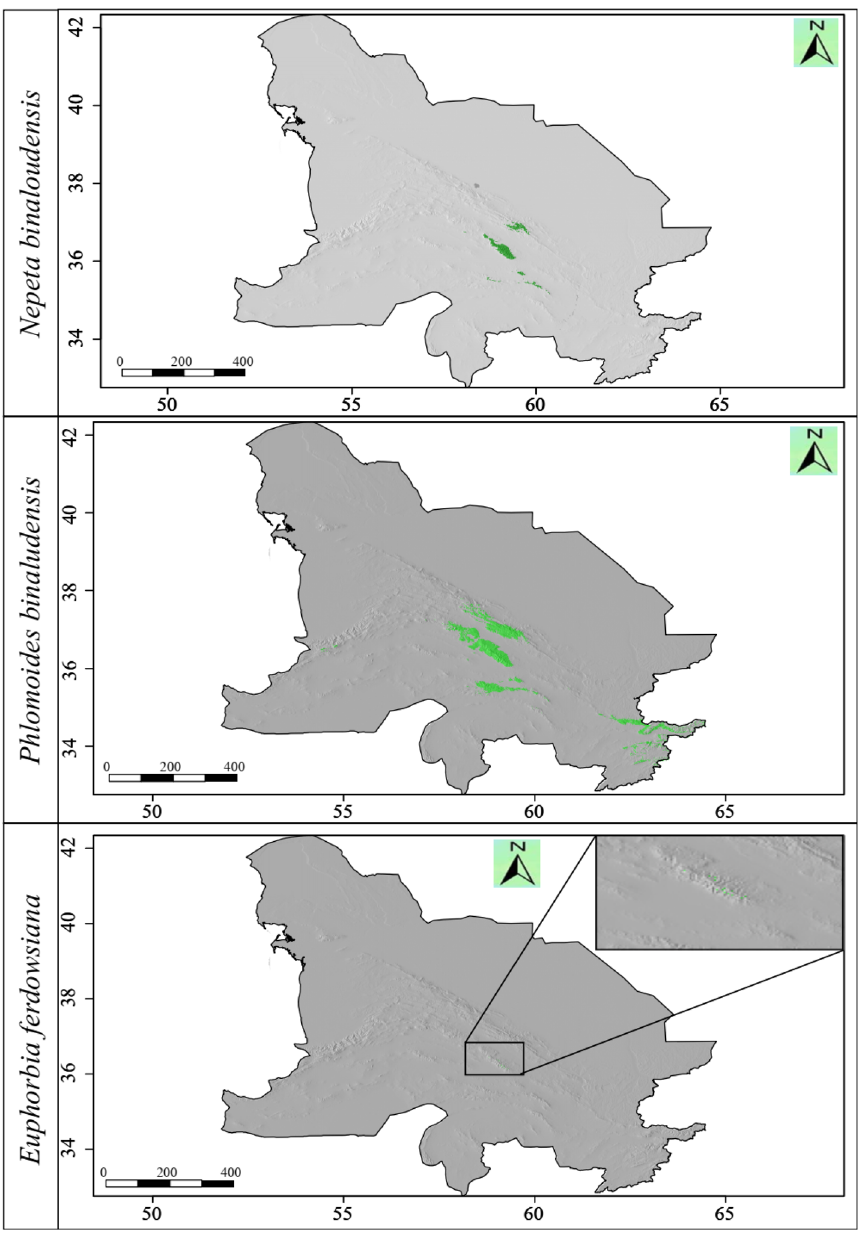
Figure 3. The habitat suitability maps of Nepeta binaloudensis , Phlomoides binaludensis , and Euphorbia ferdowsiana under the current climate conditions in the Khorassan-Kopet Dagh floristic province. Green areas indicate suitable habitats. The base map does not match that of KK boundaries and covers peripheral areas. The following maps have been generated in R ver. 3.6 (https:// www.r- proje ct.